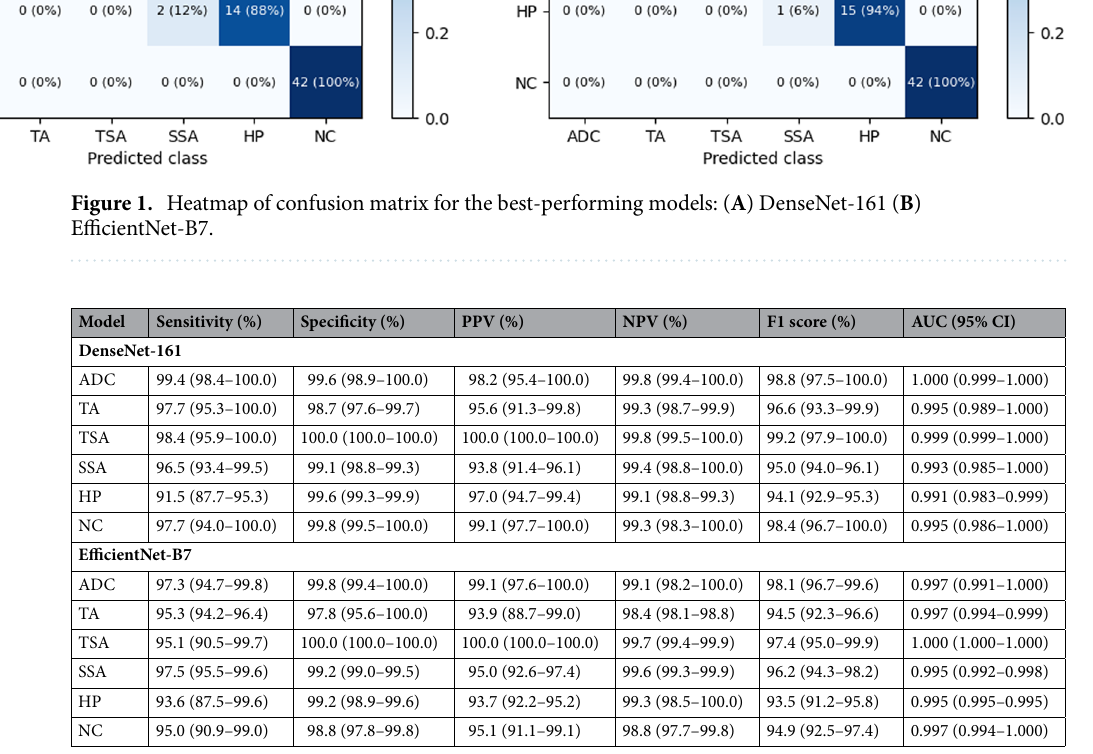
Table 2. Per-class model performances of deep learning models for six-class classification. PPV positive predictive value, NPV negative predictive value, AUC area under the receiver operating characteristic curve, CI confidence interval, ADC advanced tubular adenocarcinoma, TA tubular adenoma, TSA traditional serrated adenoma, SSA sessile serrated adenoma, HP hyperplastic polyp, NC nonspecific